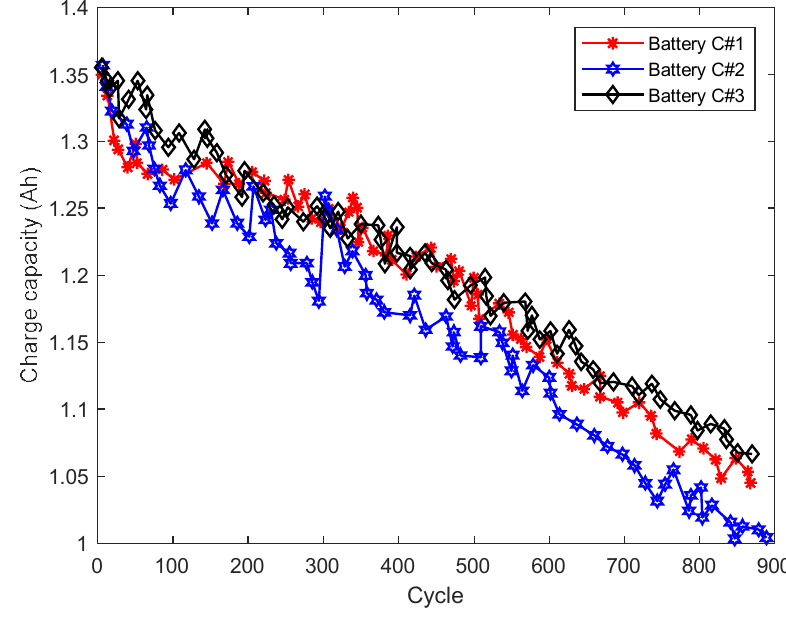
Figure 3. Summary of the experimental results of the lithium-ion battery charge capacity.